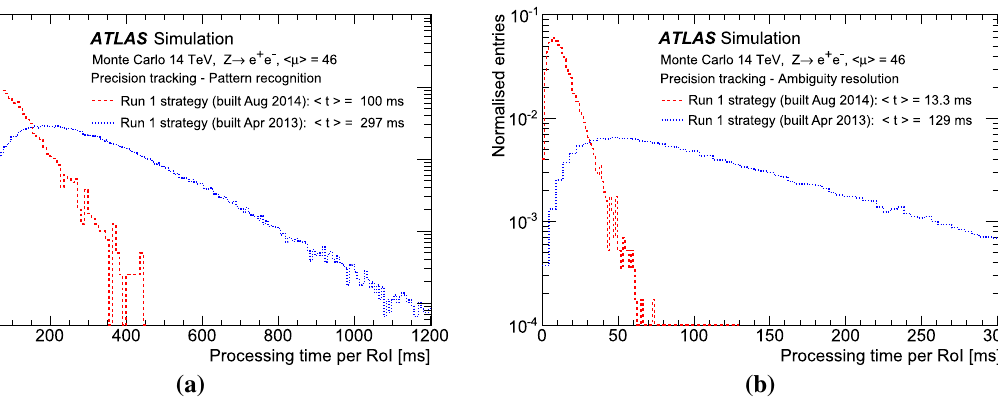
Fig. 3 The processing time for the Run 1 precision tracking pattern recognition stage ( a ), and the processing time of the ambiguity solver stage from the Run 1 precision tracking ( b ). In both cases the process-